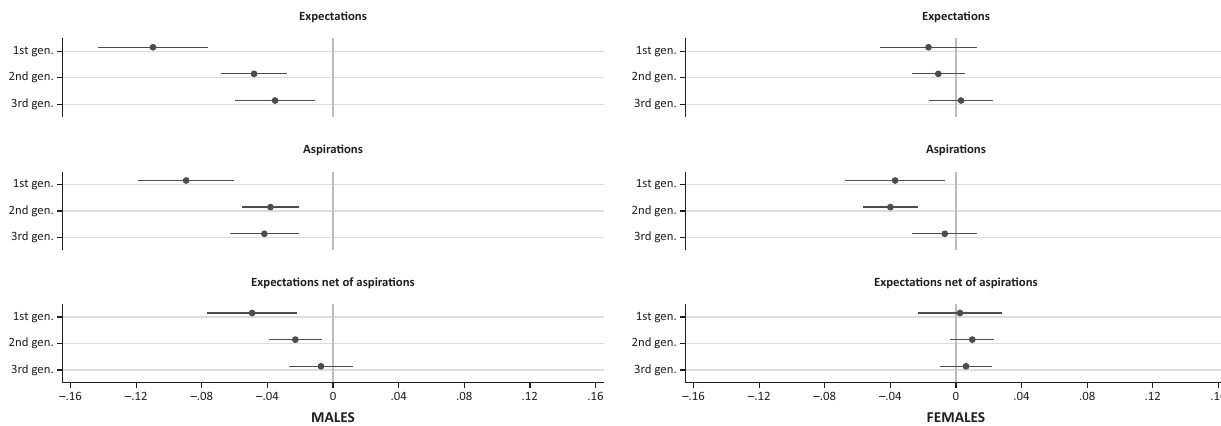
Figure 2. Differences in GTOO by immigrant generation (ref. Germans) for the male and female samples. Notes: Intercepts (males): expectations .63, aspirations .73, and expectations net of aspirations .13; intercepts (females): expectations